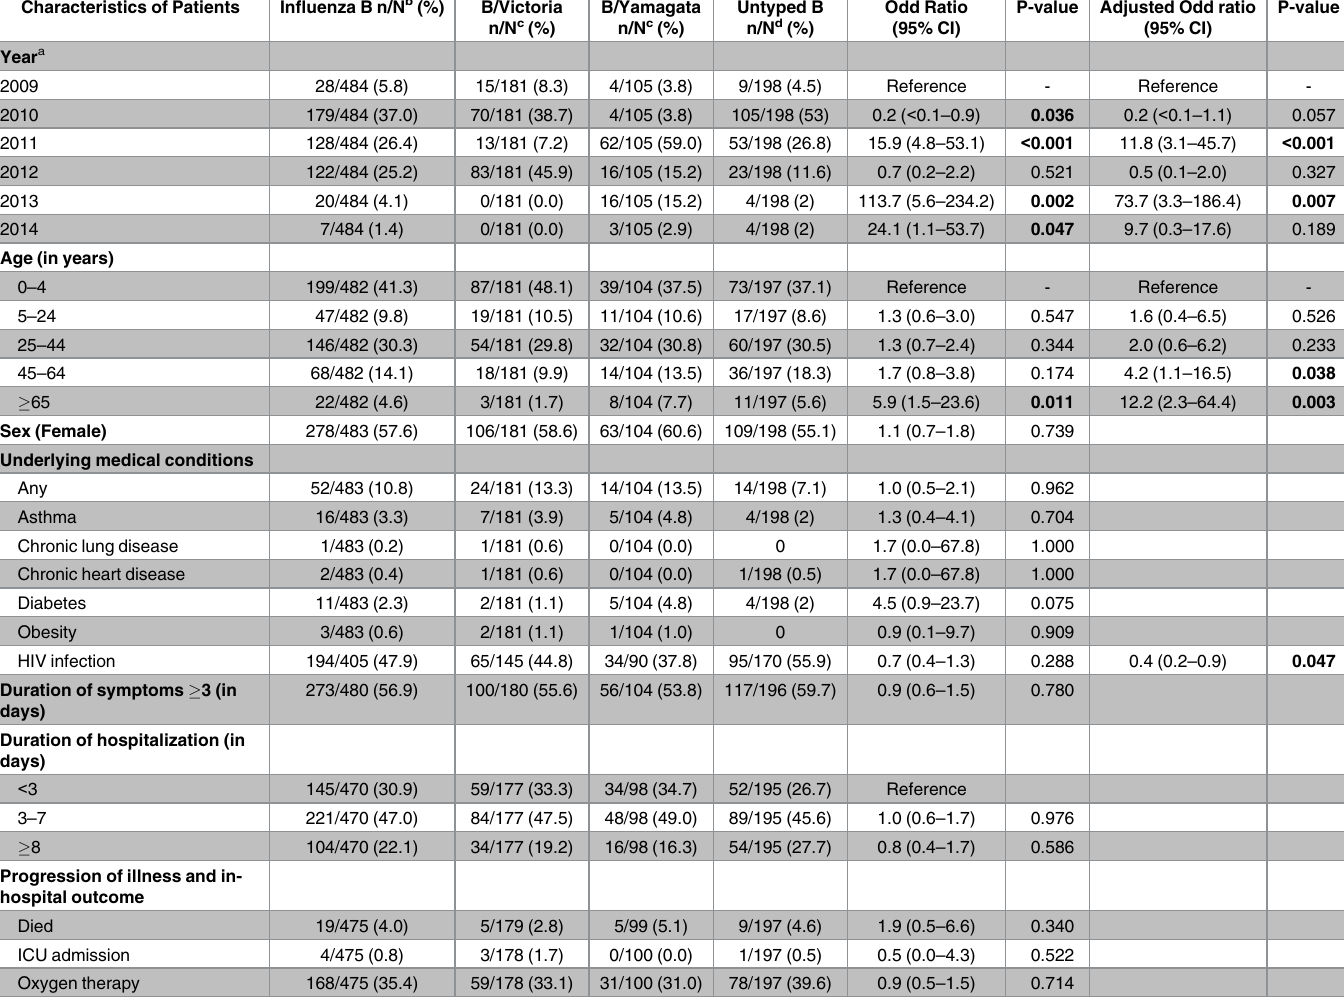
Table 2. Demographic and clinical characteristics associated with influenza B lineages, determined by multivariable logistic regression analysis, among influenza B-positive patients hospitalized with severeacute respiratory illness, South Africa, 2009–2014. Characteristics of